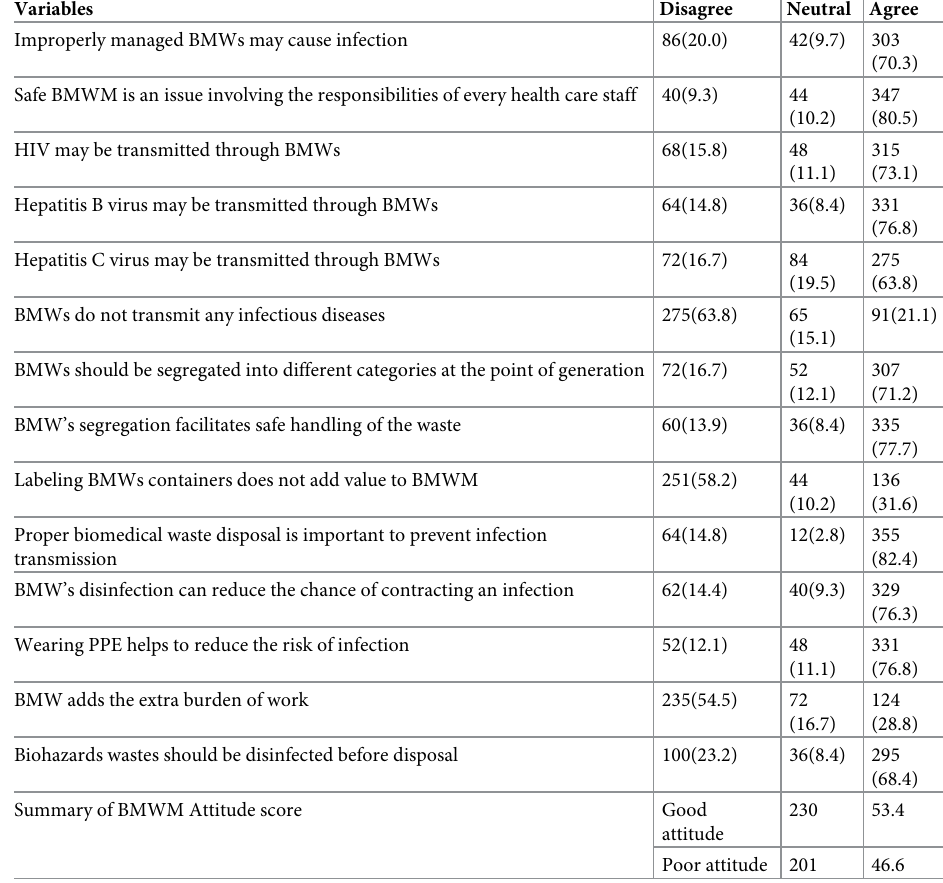
Table 4. Frequency of health care workers among each attitude item question at metropolitan cities private hospi- tals of Amhara region, Ethiopia, 2020.